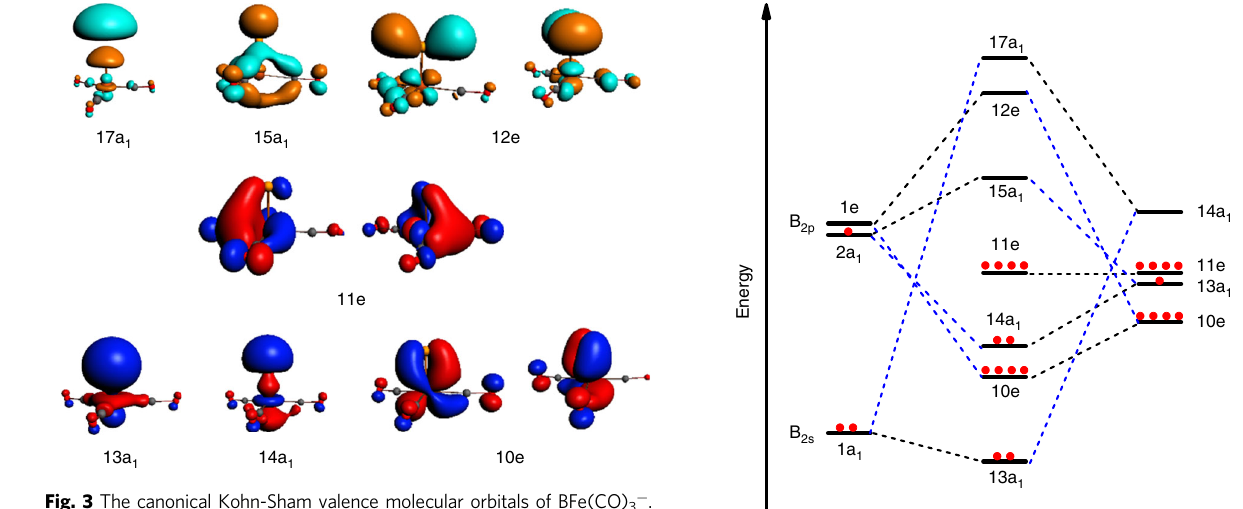
Table 5. The deformation densities Δ ρ show the direction of